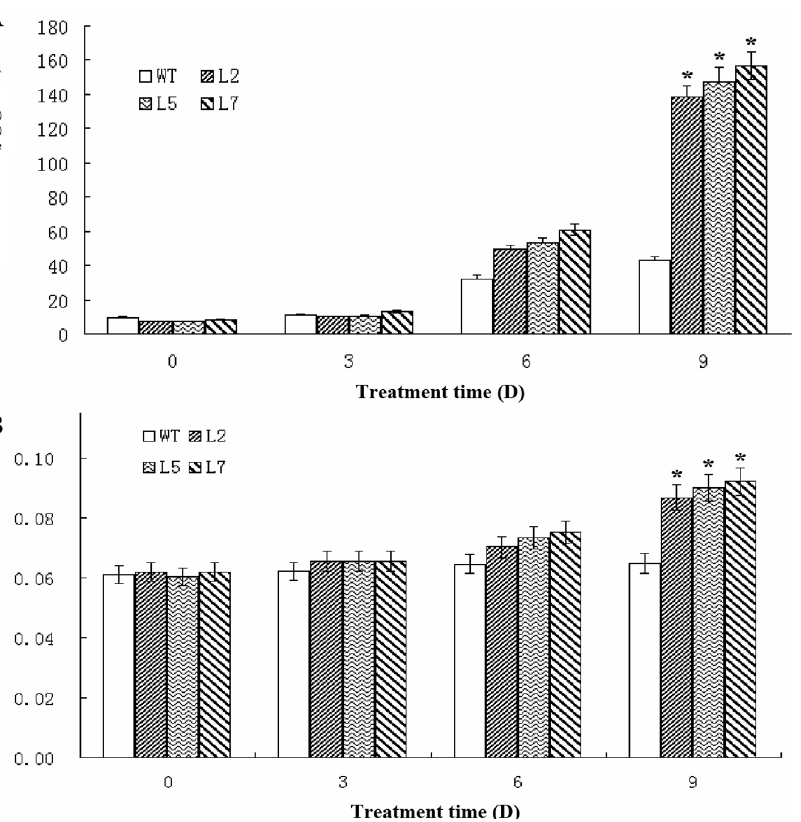
Figure 2. Measurement of soluble sugars and proline content of transgenic and WT plants after treatment with 300 mM NaCl. The WT and transgenic lines (L2, L5 and L7) were grown in pots under normal condition for 4 weeks and then leaves of plants were harvested as controls. Then, the WT and transgenic soybeans were treated with 300 mM NaCl three times with 48 hours interval, while leaves were harvested at 0, 3rd, 6th and 9th days for free proline and soluble sugars content analysis, Data represented the average of three replicates 6 SE. *indicated significant difference in comparison to the WT at P , 0.05, respectively.